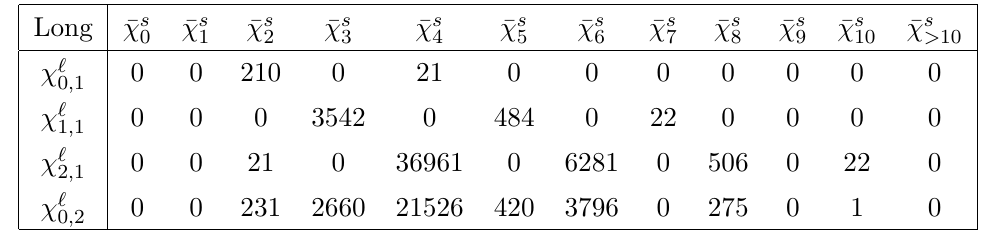
Table 5 . Coe(cid:14)cients of all short characters multiplying the (cid:12)rst four long characters that at the supergravity region in Sym N ( K 3). Note that cancellations can (but do not) occur for (cid:31) ‘